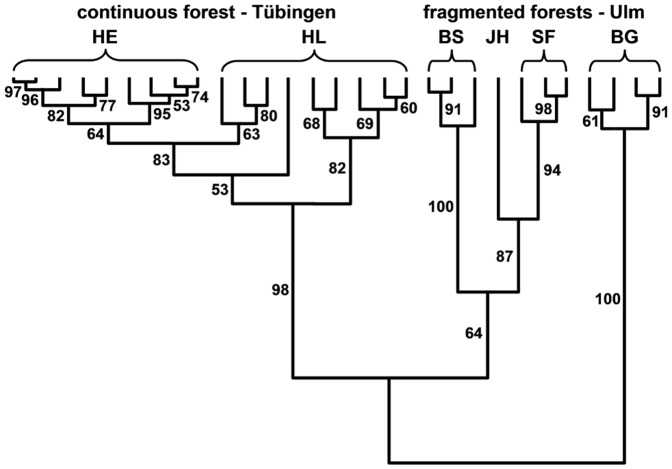
Clustering of edible dormouse populations from south western Germany using genetic distances between populations.Population structures were compared over a study period of several years (HEcont; HLcont 2001–2009; BSfrag 2007–2009; BGfrag 2006–2009; JHfrag 2009; SFfrag 2007–2009). Genetic distances between populations were estimated by Nei's genetic distance [43] and grouped with the unweighted pair group method (UPGMA). Numbers indicate the reliability of nodes giving the bootstrap frequencies (%).